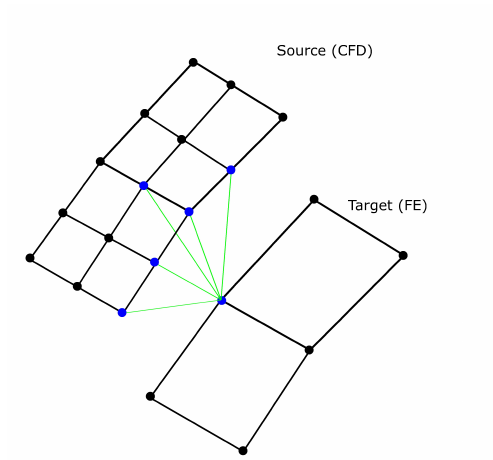
Figure 10. Distance-based average.